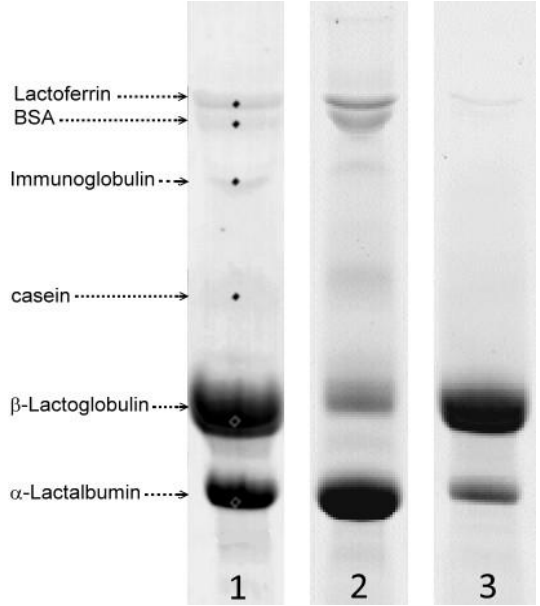
Figure 1. Typical distribution of the whey proteins before and after processing with SCO as measured with SDS-PAGE: 1 , Initial whey protein isolates (WPI); 2 , precipitate (alpha) fraction; 3 , soluble (β) fraction. BSA, bovine serum